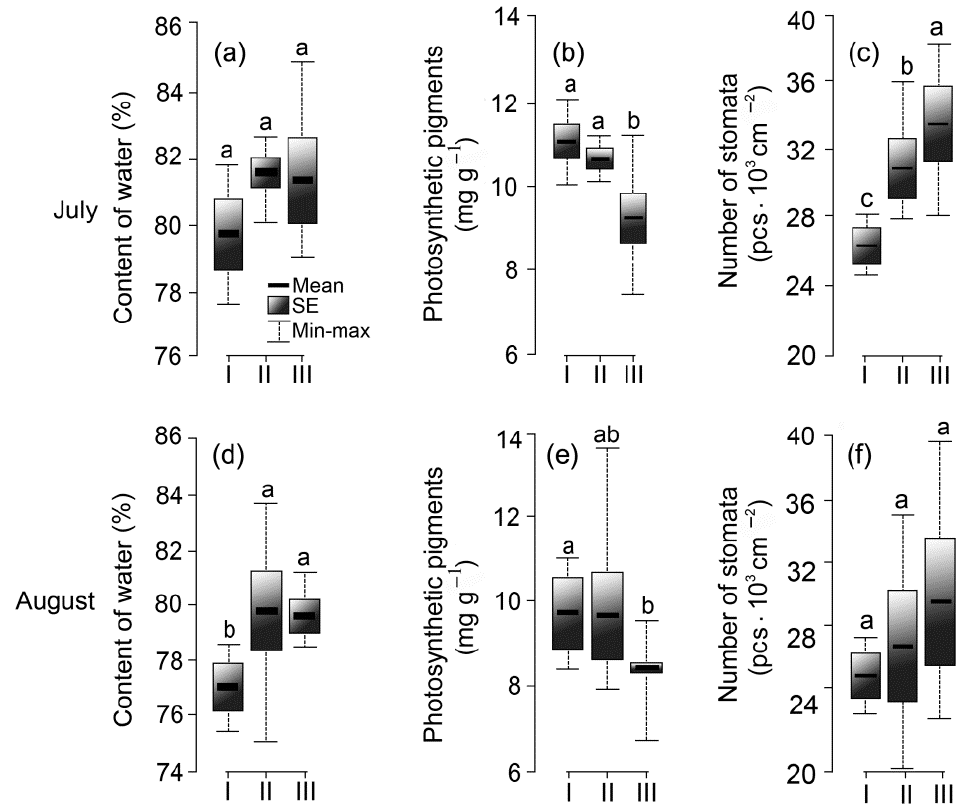
Figure 3. The content of water (July— a , August— d ), photosynthetic pigments (July— b , August— e ) and the number of stomata per leaf area unit (July— c , August— f ) depending on the ripening degree of potato plants and the growing season. I—early variety; II—medium-early variety; III— mid-season.